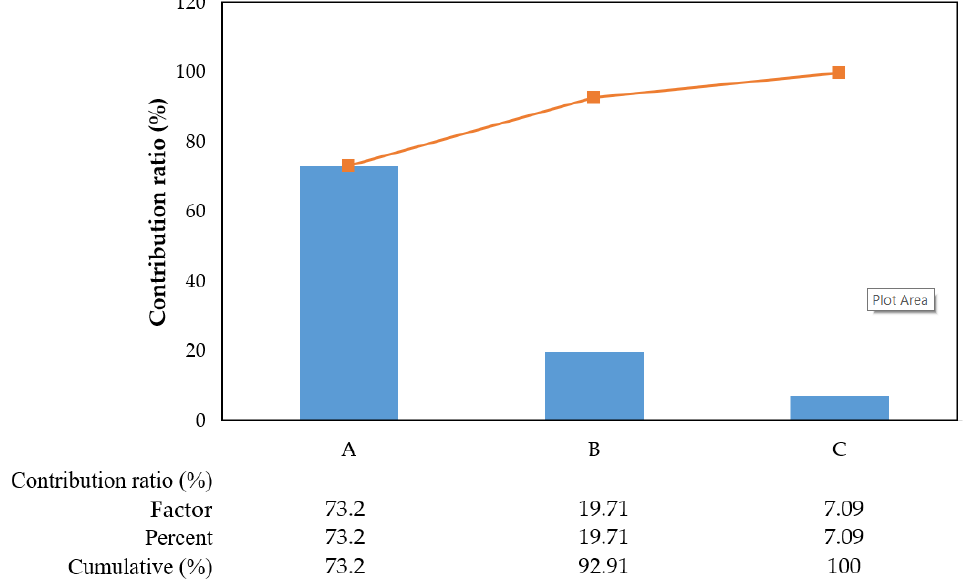
Figure 4. Pareto ANOVA analysis of optimum electropolishing parameter on material removal rate. Table 11. Calculation of the contribution ratio of electropolishing machining parameters.